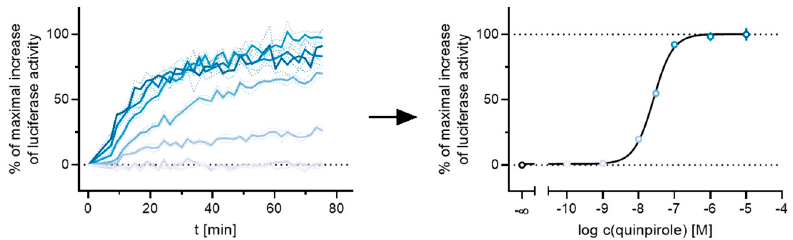
Figure 3. Exemplary results of a live-cell measurement at the D 2long R. HEK293T cells stably expressing ELucN- β arr2 and D 2long R-ELucC were stimulated with different concentrations of the standard agonist quinpirole. The time-dependent increase in luminescence was recorded and the AUC after 50 min was used to generate a concentration-response curve.